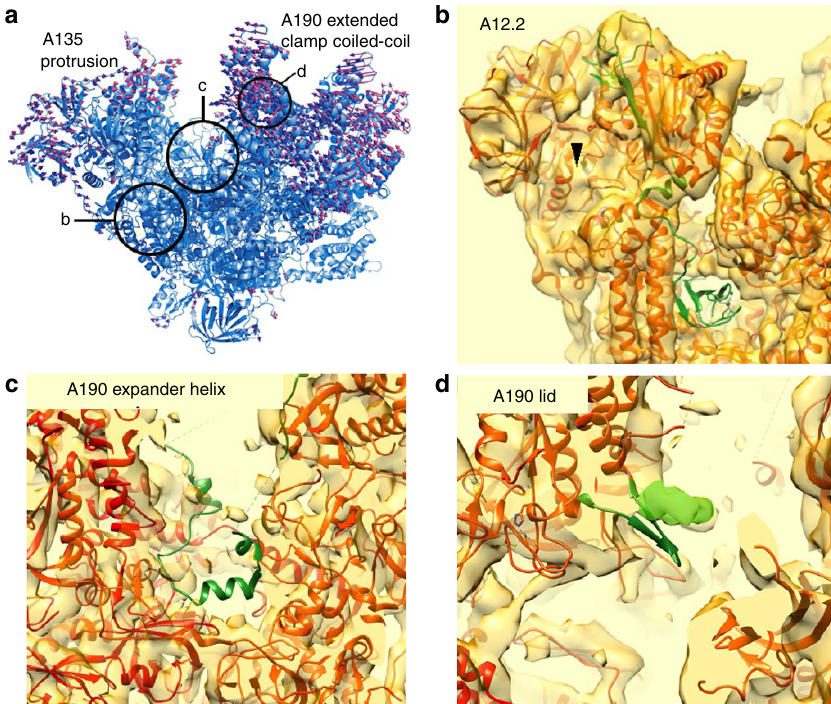
Figure 3 | Structural changes of Pol I in the Rrn3-bound conformation as compared with the crystal form. ( a ) Flexible fitting of the atomic structure of Pol I into the cryo-EM structure of the Pol I- Rrn3 complex. The displacement vectors (red) associated to each residue when moving from the crystal structure (blue) to the cryo-EM model show the closing of the cleft and the upward movement of the A43-A14 stalk. Structural regions enlarged in b – d are highlighted by circles. ( b ) Crystal structure of the A12.2 subunit (green) whose C-terminal TFIIS-like domain is not located in the pore of the Pol I-Rrn3 cryo-EM structure. ( c ) Crystal structure of the expander helix (green) of the A190 subunit (residues 1,361–1,378) which is not resolved in the cryo-EM structure. ( d ) Position of the lid loop of subunit A190 (residues 368–380) in the crystal structure (green ribbons) as compared with the cryo-EM structure (green